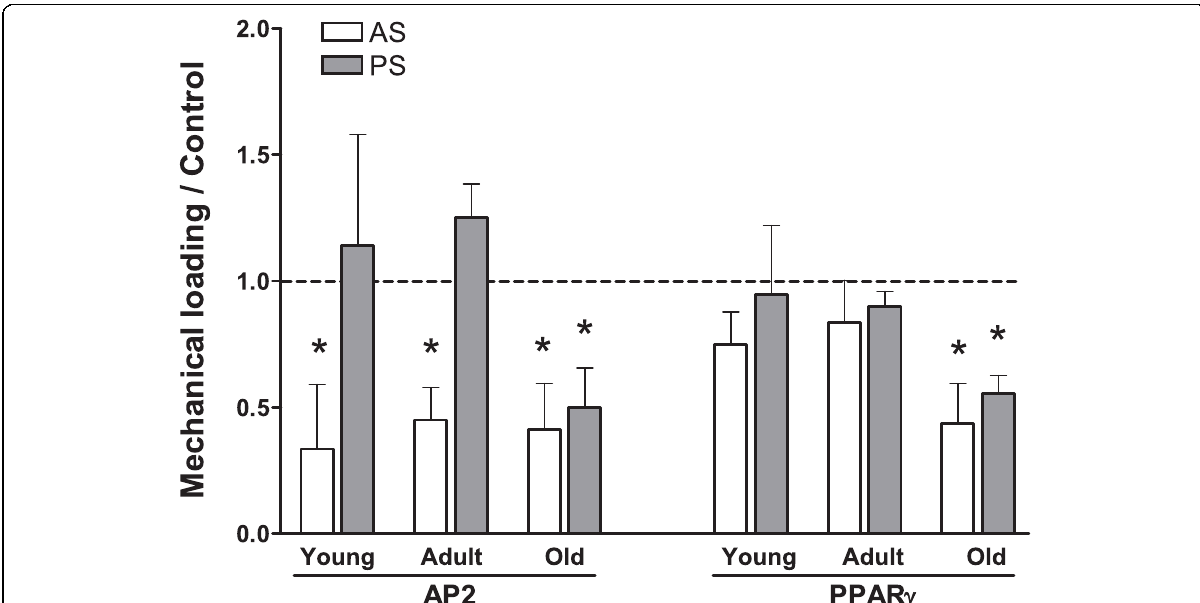
Figure 8 Comparison of the effect of pre-strain (PS) or simultaneous strain and adipogenic induction (AS) . The levels of AP2 and PPAR g were normalized to b -actin and compared to the levels in NS groups that were induced for 14 days. Simultaneous strain applied during adipogenic induction was more effective at reducing adipogenic potential in ADSCs. *: P < 0.05, compared to 1. N =